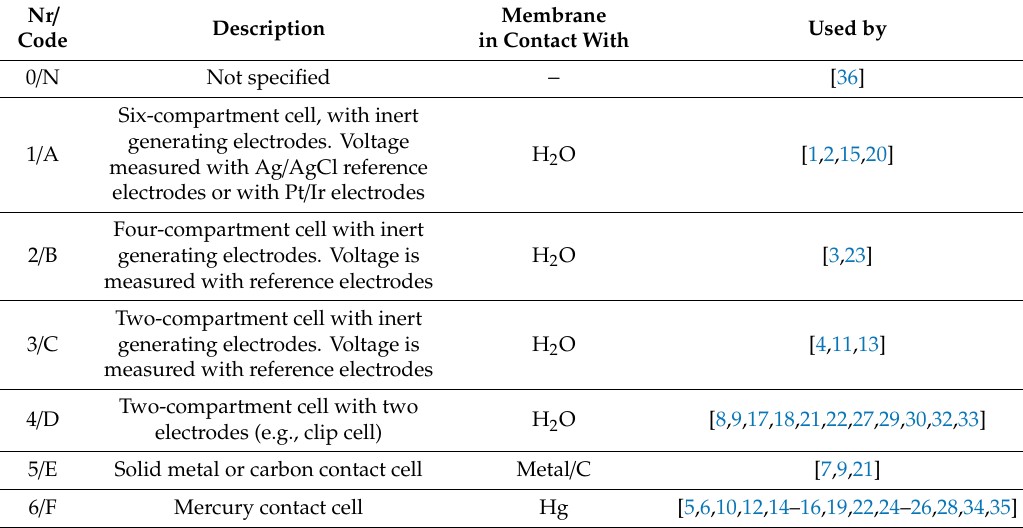
Table 3. Used measuring